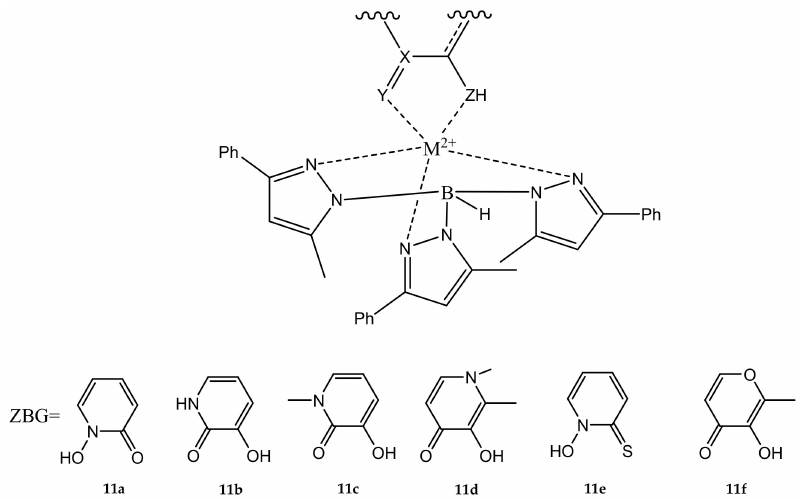
Figure 11. Zinc binding groups (ZBGs) in [(Tp Ph,Me )Zn(ZBG)] complexes: 1-hydroxy-2(1H)-pyridinone ( 11a ); 3-hydroxy-2(1H)-pyridinone ( 11b ); 3-hydroxy-1-methyl-2(1H)-pyridinone ( 11c ); 3-hydroxy- 1,2-dimethyl-4(1H)-pyridinone ( 11d ); 1-hydroxy-2(1H)-pyridinethione ( 11e ); 3-hydroxy- 2-methyl- 4-pyrone ( 11f )